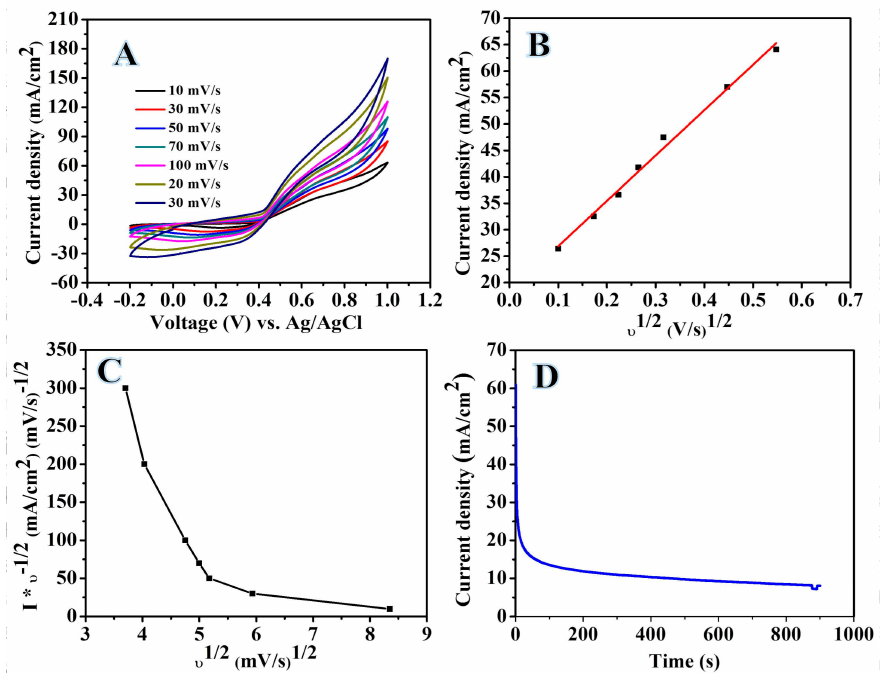
Figure 10. ( A ) CV of composite NF electrodes in 1 M KOH aqueous solution after adding 1 M of urea at di ff erent scan rate values (10, 30, 50, 70, 100, 200, and 300 mV / s). ( B ) Variations in the square root of the scan rate as a function of the CD of UO at composite NF electrodes. ( C ) The scan rate normalized current density plotted against the scan rate. ( D ) Chronoamperogram of composite NF electrodes in 1 M KOH aqueous solution containing 1 M of urea solution at 600 mV (Ag / AgCl) for 900